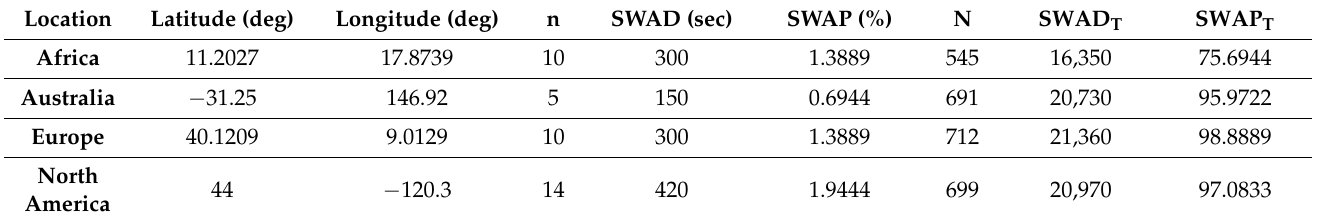
Table 4. System-wide coverage parameters with respect to a scenario duration of 6 h, i.e., 21,600 s.